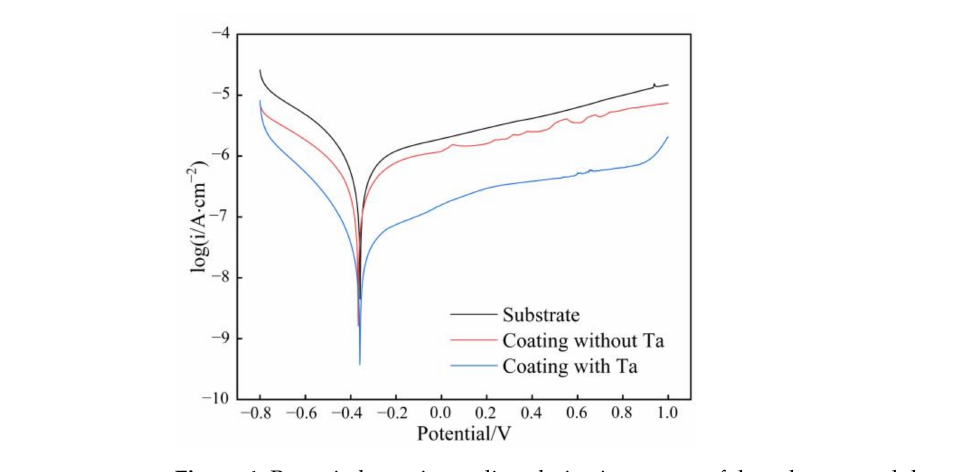
Figure 4. Potentiodynamic anodic polarization curves of the substrate and the coatings in the neutral environment (3.5 wt.% NaCl